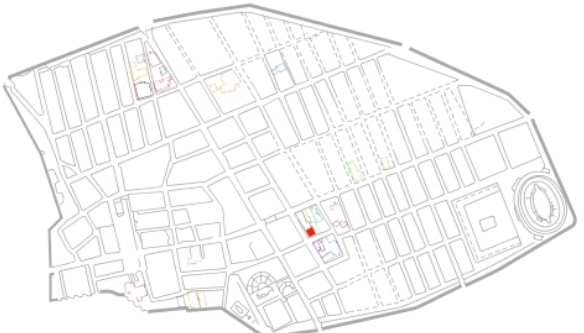
Figure 1. General plan of Pompeii. The red square highlights the location of the Domus of Stallius Eros